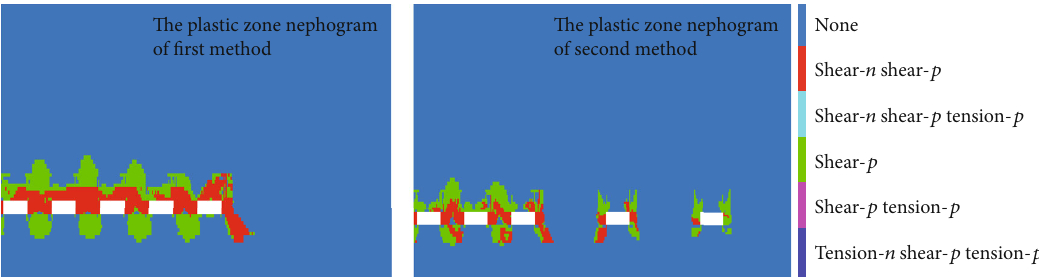
Figure 10: The plastic zone nephogram of the coal pillar of the fi fth